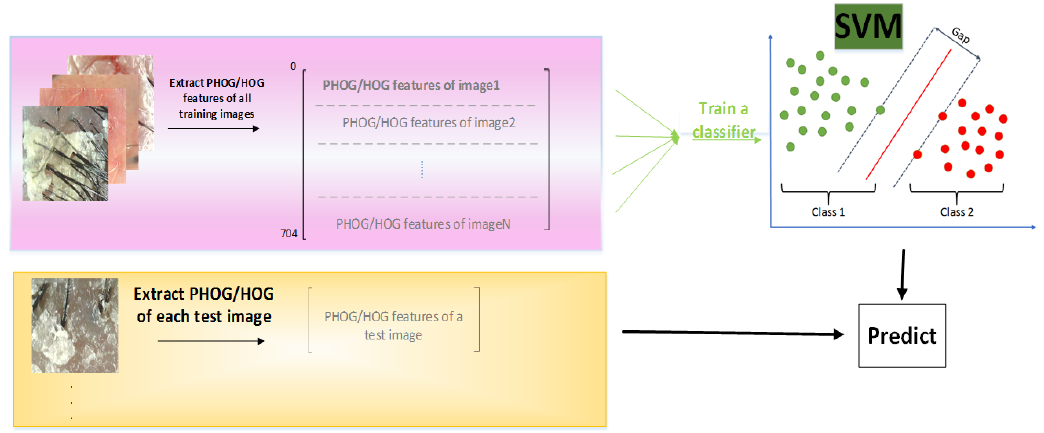
Figure 6. Pyramid histogram of oriented gradients (PHOG)/histogram of oriented gradients (HOG) with the SVM method.